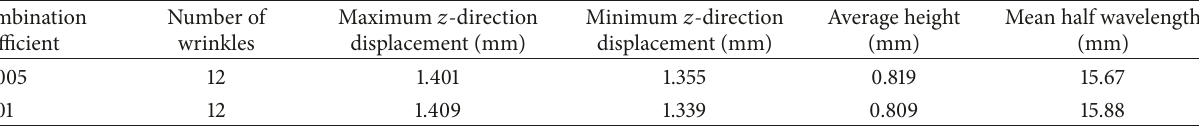
Table 8: Influence of initial geometric imperfections.